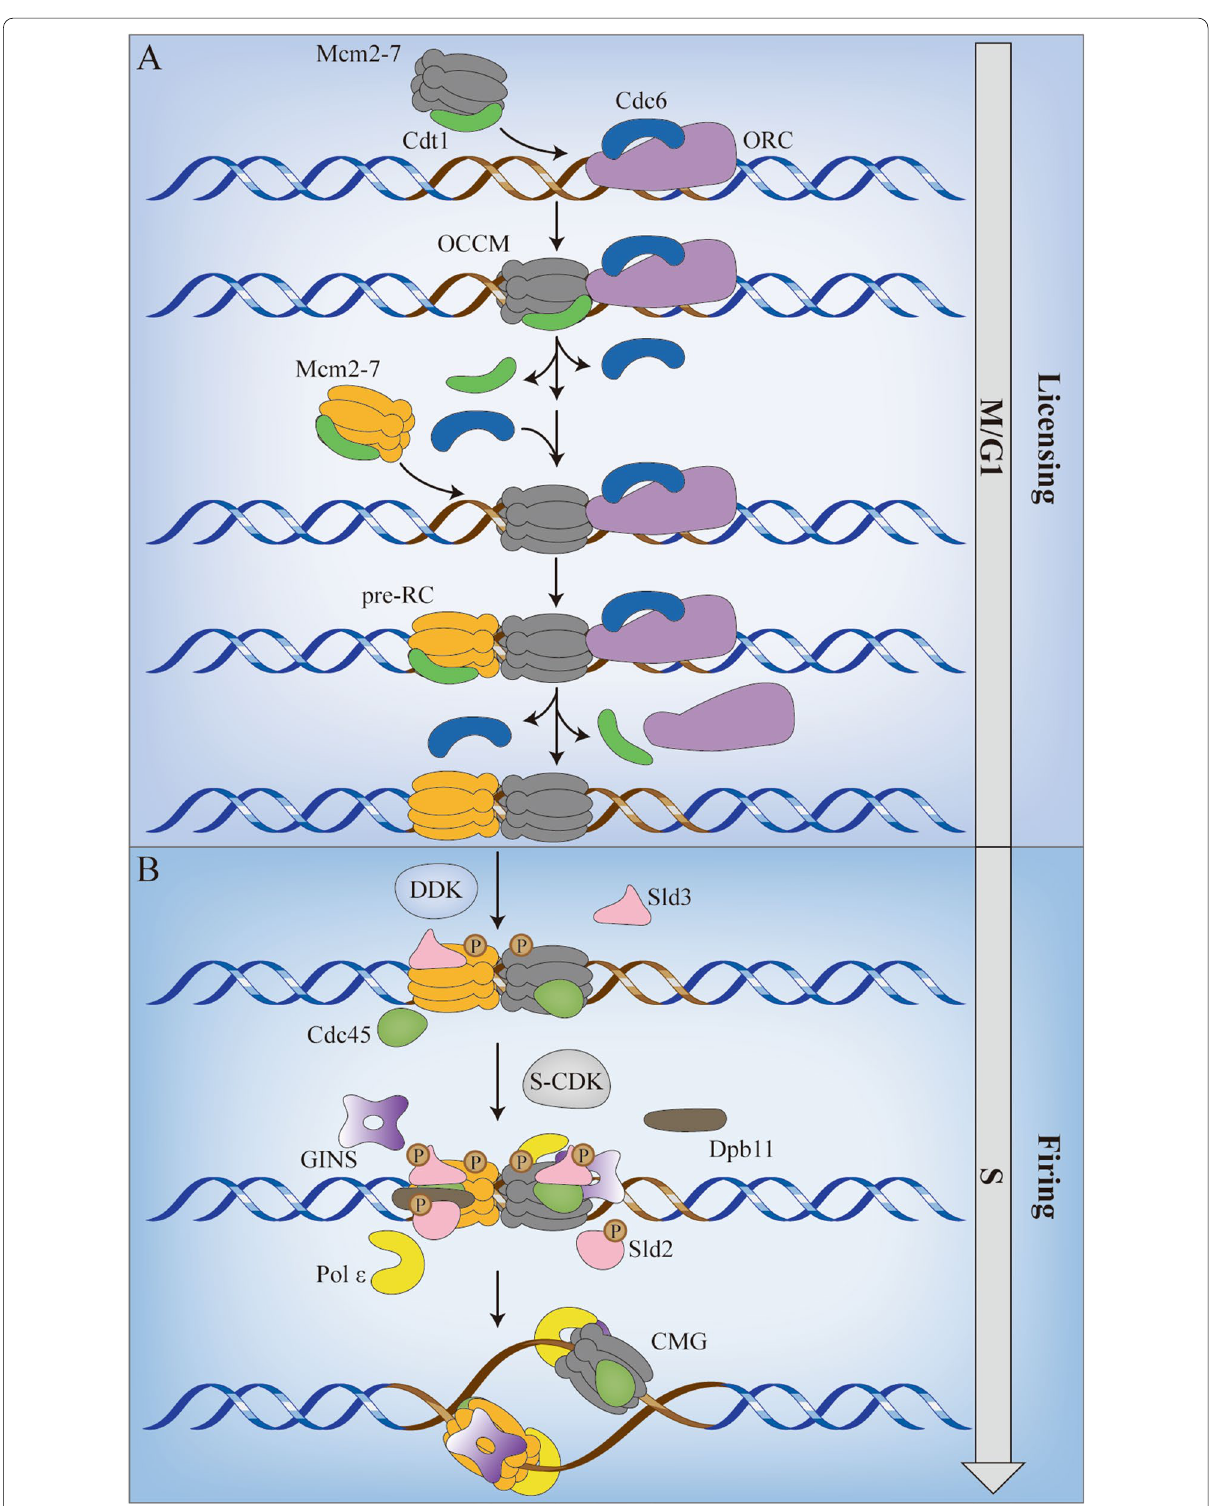
Fig. 1 MCM2 in DNA Replication. The two-step mechanism ensures a single round of replication. A The loading of Mcm2-7 only occurs in late M/ G1 phase. B The activation of Mcm2-7 is mediated by DDK and S-CDK in S